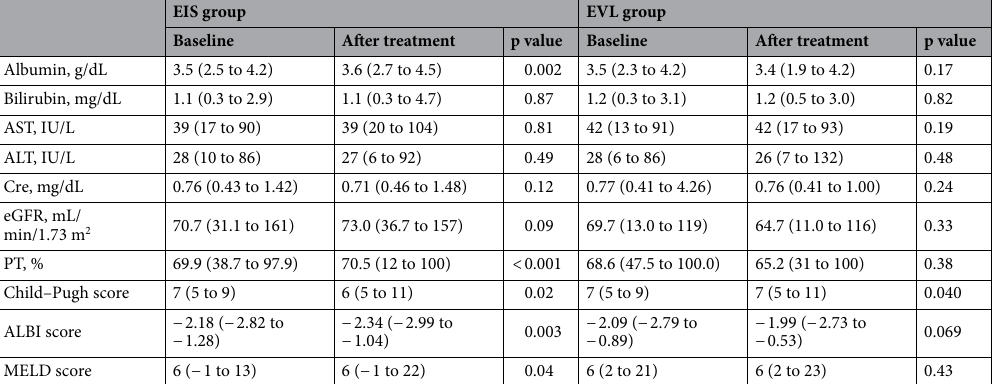
Table 3. Liver functions at baseline and 3 months after variceal treatments. ALBI albumin–bilirubin, ALT alanine aminotransferase, AST aspartate transaminase, Cre creatinine, eGFR estimated glomerular filtration rate, EIS endoscopic injection sclerotherapy, EVL endoscopic variceal ligation, MELD the model for end-stage liver disease, PT prothrombin time.